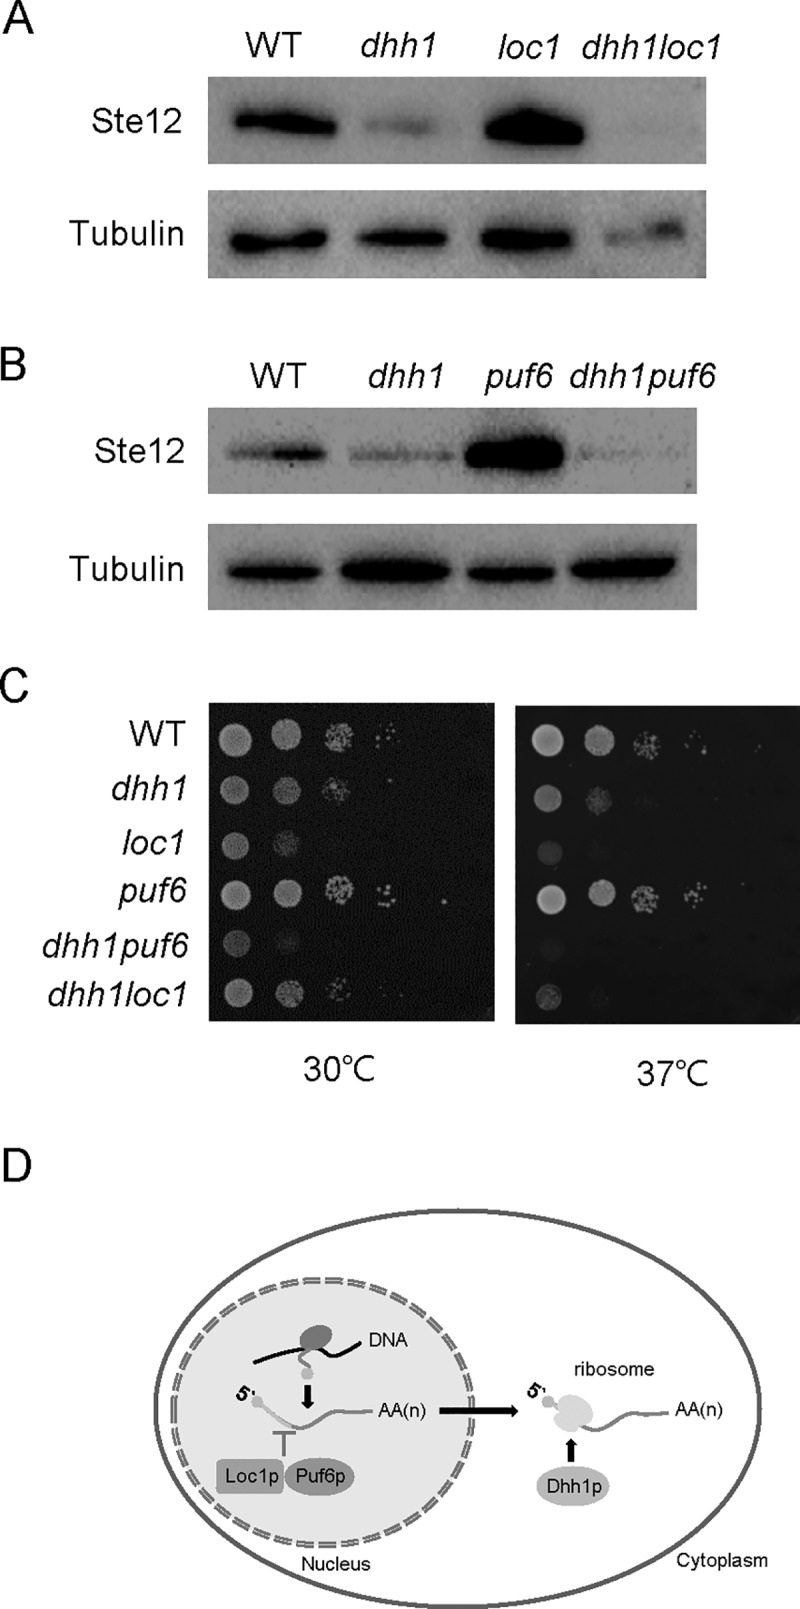
Genetic interactions of dhh1, loc1, and puf6 mutations revealed by double-mutant analysis.(A) Ste12-HA protein levels were measured in the wild-type, dhh1, loc1, and dhh1loc1 cells by Western blot analysis. Tubulin was used as a loading control. (B) Ste12-HA protein levels were measured in wild-type, dhh1, puf6, and dhh1puf6 cells. (C) Growth defects of the dhh1loc1 and dhh1puf6 double-mutant strains. Ten-fold serial dilutions of overnight cultures of wild-type, dhh1, loc1, puf6, dhh1loc1 and dhh1puf6 cells were spotted on YEPD plates, which were incubated at 30°C and 37°C for 2 days and then photographed. (D) Model of the regulation of STE12 mRNA by Loc1, Puf6, and Dhh1. Loc1 and Puf6 are localized predominantly in the nucleus and repress the expression of STE12 at the post-transcriptional level. Dhh1 positively regulates the translation of the STE12 mRNA, possibly downstream of Loc1 and Puf6.